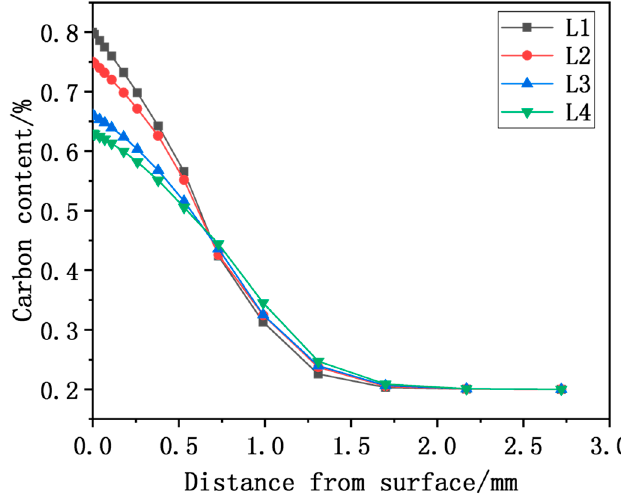
Figure 12. Simulation of carbon content distribution with different diffusion times.